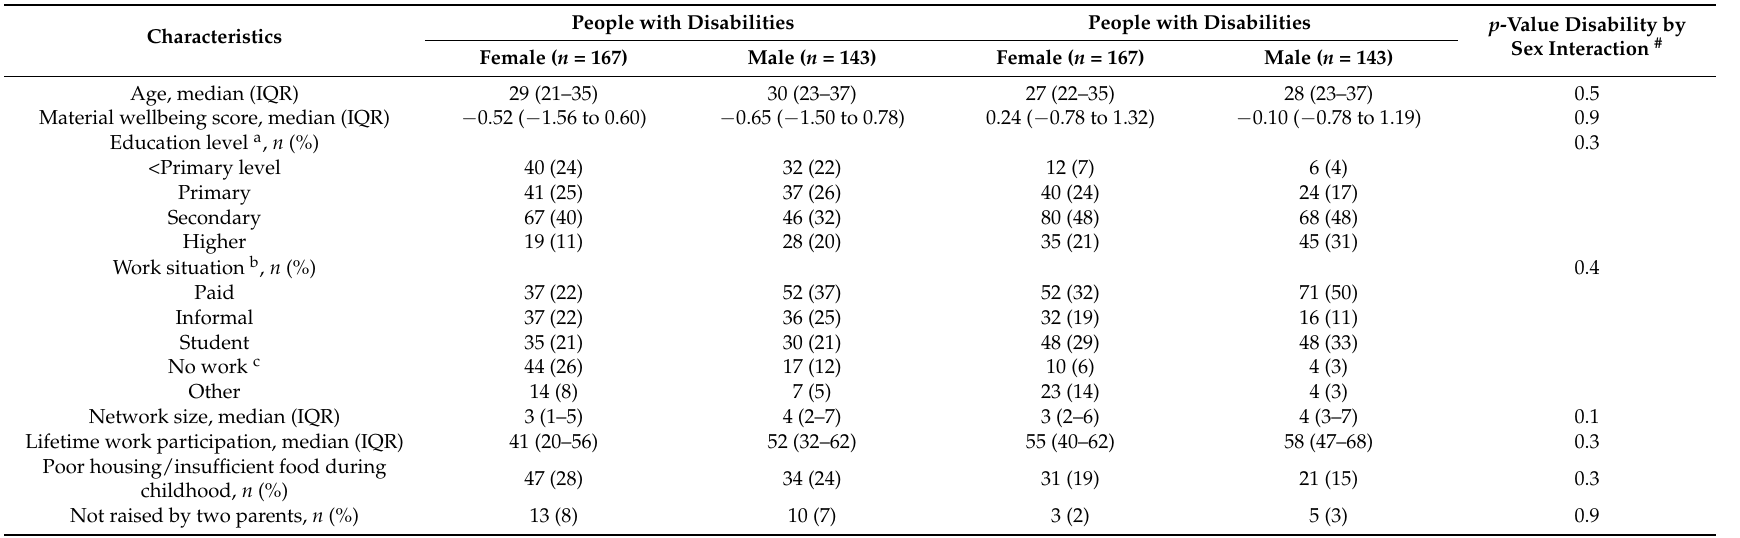
Table 1. Study population